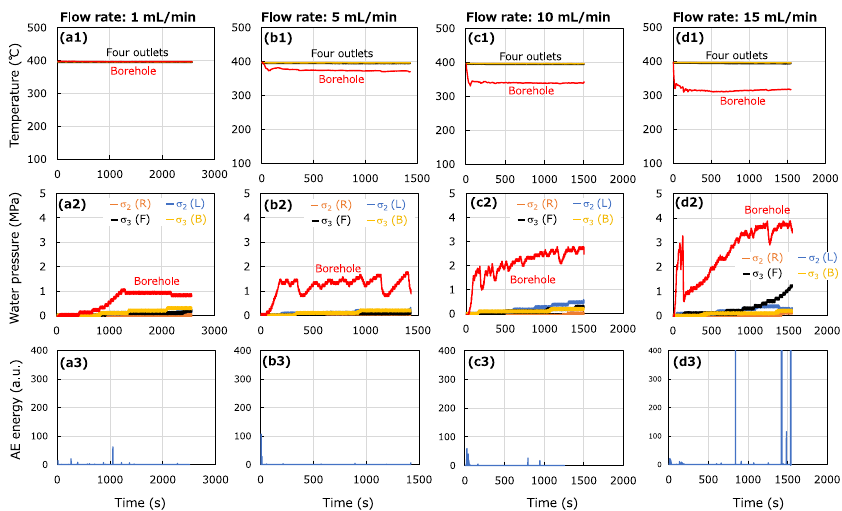
Fig. 6 Temporal changes in temperatures and water pressures for the borehole and four outlet faces, and